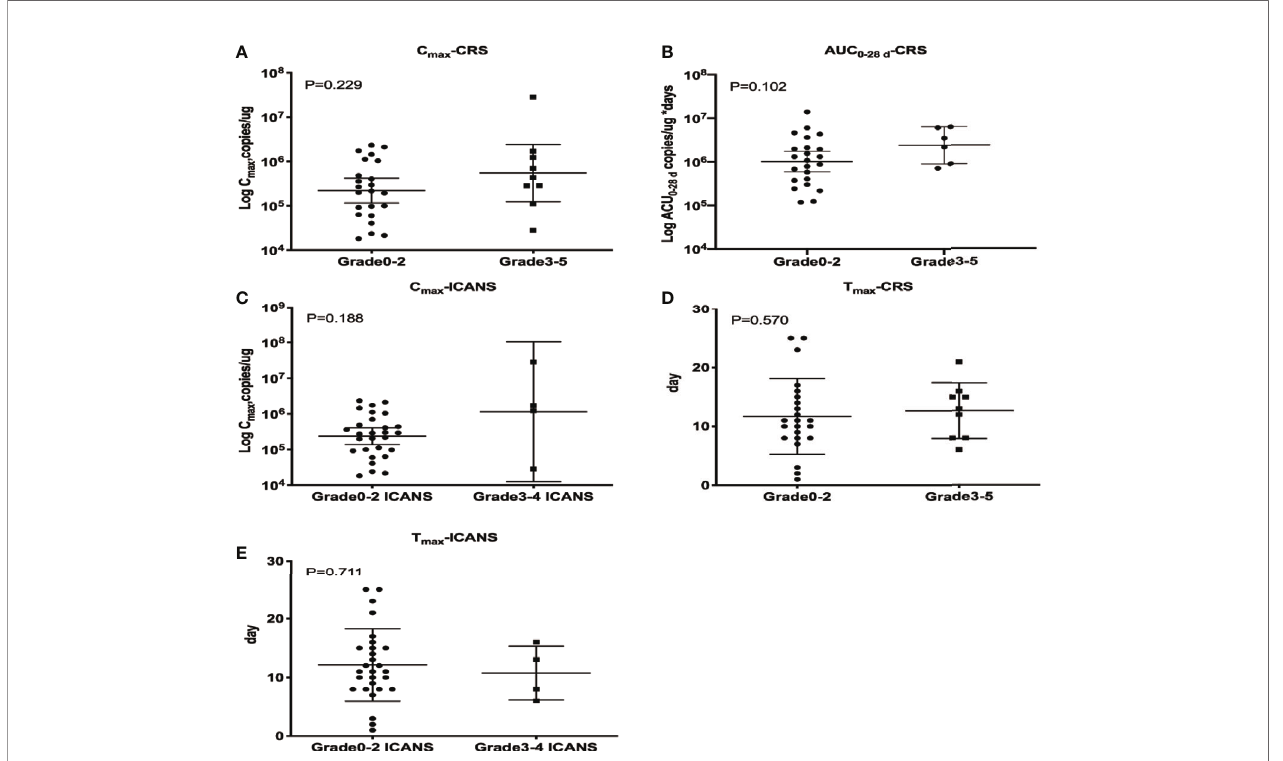
FIGURE 4 | Relationship between cellular kinetics and AEs. Relationships between C max and CRS (A) , AUC 0 – 28 d and CRS (B) , C max and ICANS (C) , T max and CRS (D) and T max and ICANS (E) . (A, B) Patients with sCRS exhibited higher CD19/22 CAR T C max and AUC 0 – 28 d values than those with grade 0 – 2 CRS, but these differences were not statistically signi fi cant (P = 0.229 and P = 0.102, respectively). (C) Patients with sICANS exhibited a higher C max than those with low/no ICANS, but this difference was not statistically signi fi cant (P = 0.188). (D, E) Neither CRS nor ICANS was correlated with T max (P = 0.570 and P = 0.711, respectively).